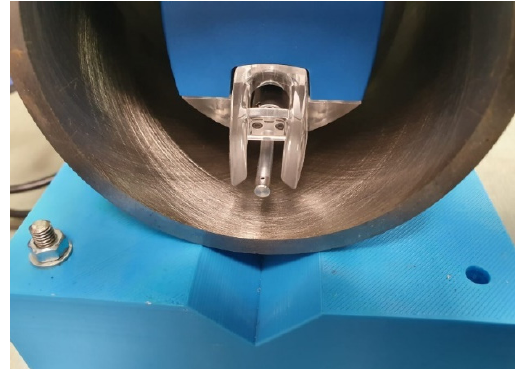
Figure 3. Contact roughness meter .